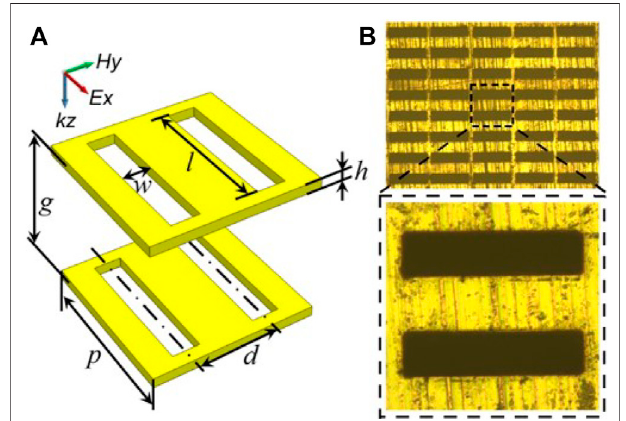
FIGURE 1 | Schematic diagram (A) of the bilayer THz metamaterial fi lter withaperiodof p =180 μ m,rectangularholelengthof l =150 μ m,widthof w = 30 μ m, central distance of d = 45 μ m, thickness of h = 10 μ m, and spacing of g = 130 μ m. Optical microscopy imaging (B) of the fabricated metamaterial and partial enlarged